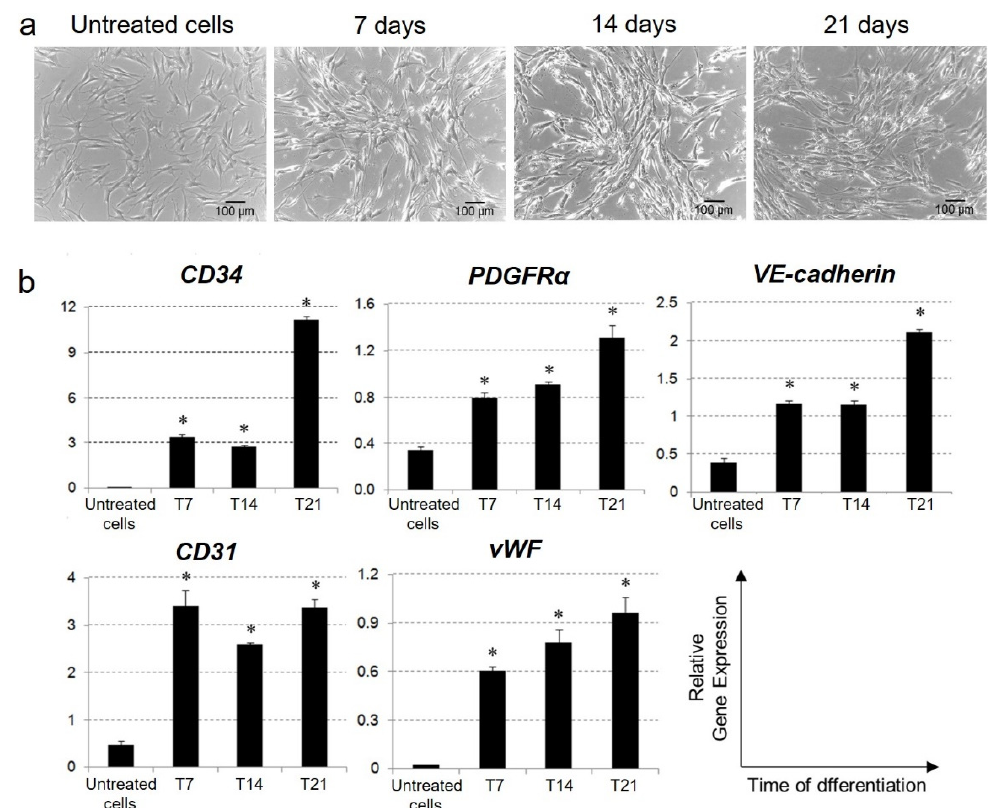
Figure 3. Morphology and gene expression profile of differentiated Ad-MSCs. ( a ) Phase-contrast micrographs of Ad-MSC population cultured in proliferative medium (untreated cells) or in endothelial differentiative medium for 7, 14 and 21 days (Scale bar: 100 µm). ( b ) Real Time PCR analysis of endothelial mRNAs expression on untreated cells or in Ad-MSCs cultured in induction medium for 7 (T7), 14 (T14) and 21 (T21) days. Relative gene expression was defined as an n-fold difference referred to the calibrator sample (HUVEC cultures); the housekeeping gene (GAPDH) expression was considered to validate the amplification efficiency of target genes. In the right bottom of the figure, the measured units on the x-axis and y-axis of other graphs are indicated. (* p < 0.01). Abbreviations: PDGFR α , Platelet Derived Growth Factor Receptor Alpha ; VE-cadherin , vascular endothelial cadherin ; vWF , von Willebrand factor .